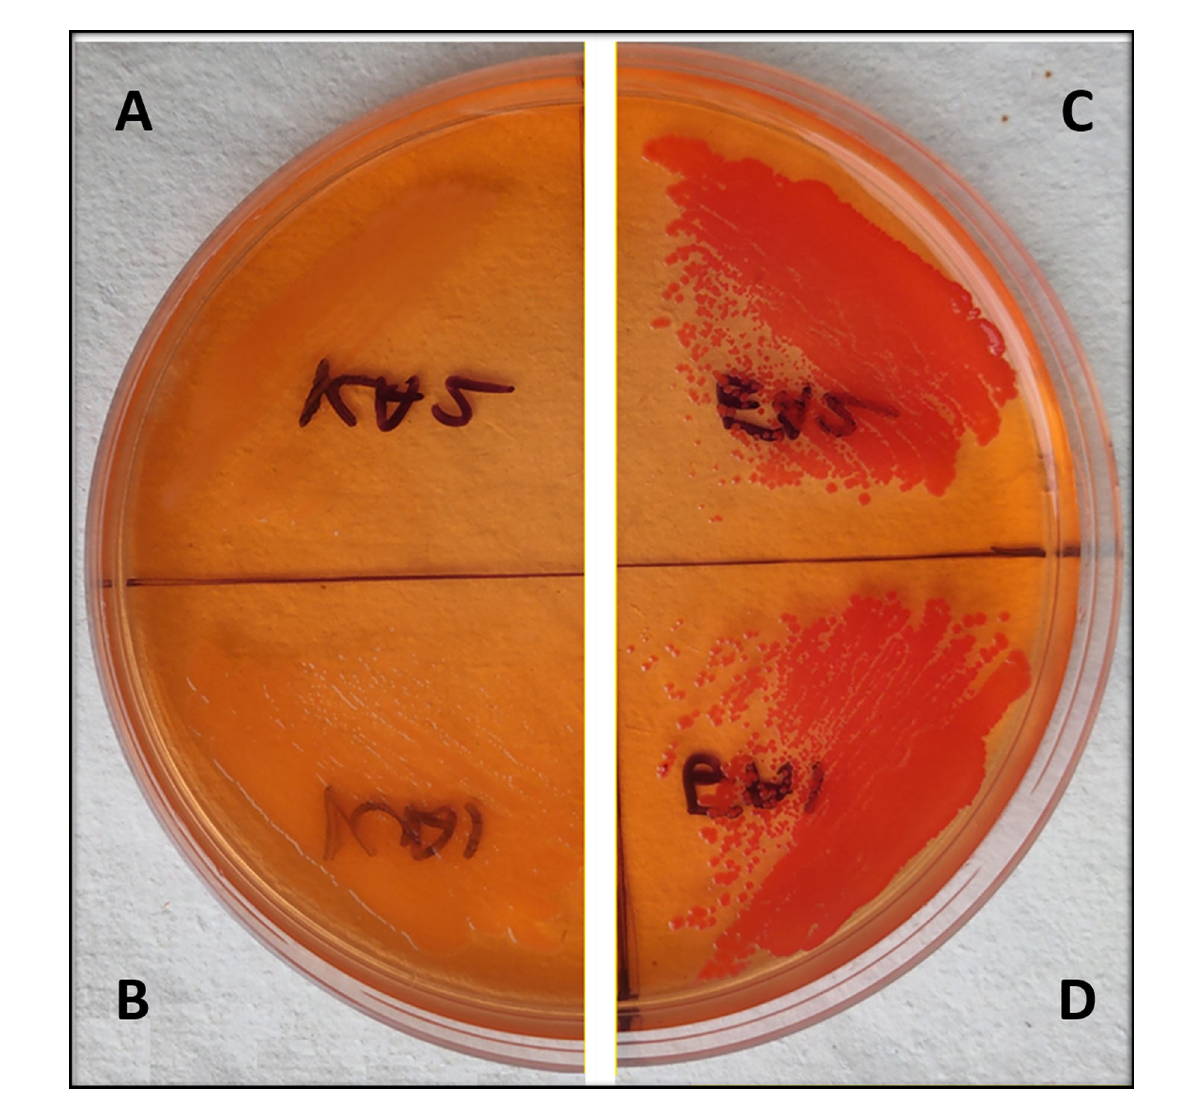
FIGURE4 (A–D) Congo red agar plate assay of EcN and K12 cells with csgD knockdown. (A,B) show csgD -KD cells of EcN and K12, respectively, while (C,D) show control cells of EcN and K12. The Congo red agar plates show a yellowish-white colony in mutated cells, suggesting a decrease in the curli